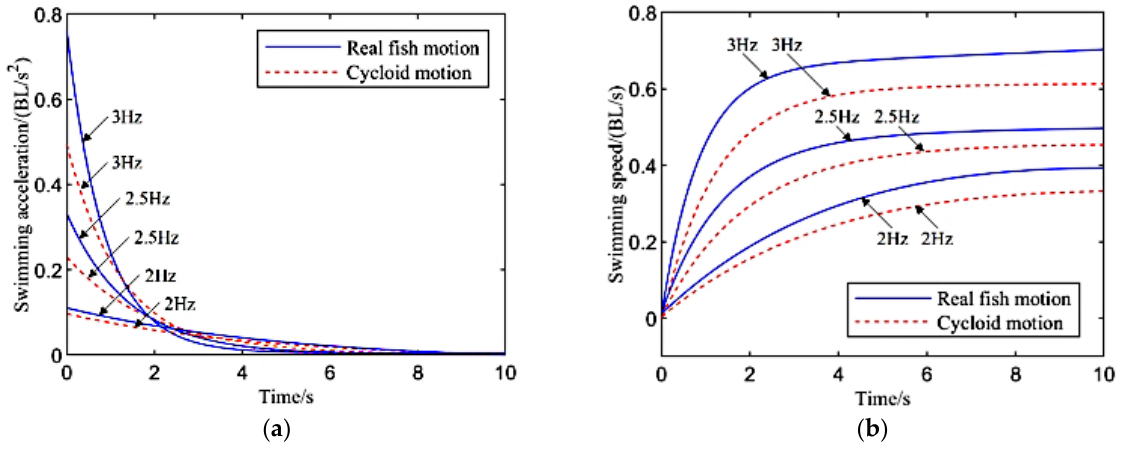
Figure 8. Acceleration ability of robotic fish under different undulatory motions: ( a ) the acceleration during swimming; ( b ) the velocity during swimming.